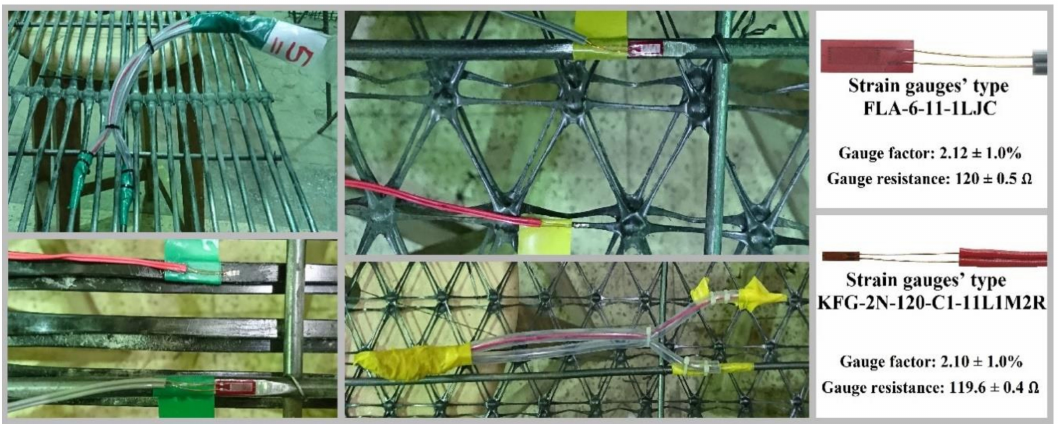
Figure 3. Fixing, isolation, protection, and types of used strain gauges.